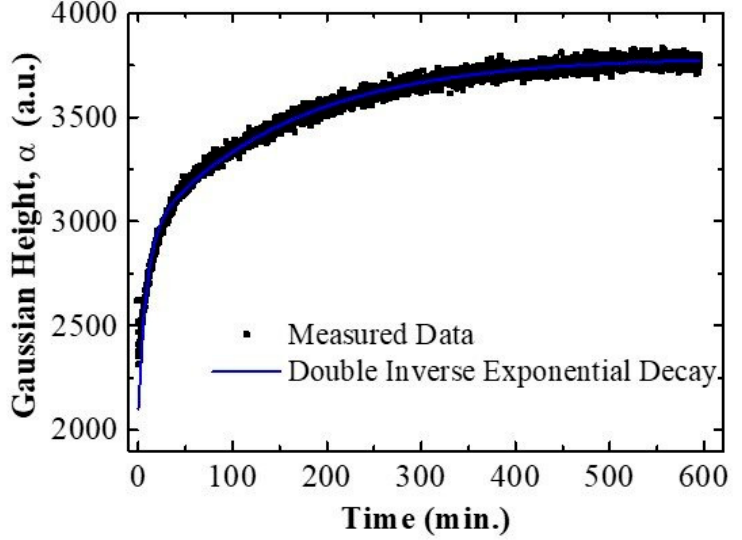
Figure 8. The graph represents the best fitting obtained with the model being applied for the time evolution of the signal for Hy-NAA-GIFs.